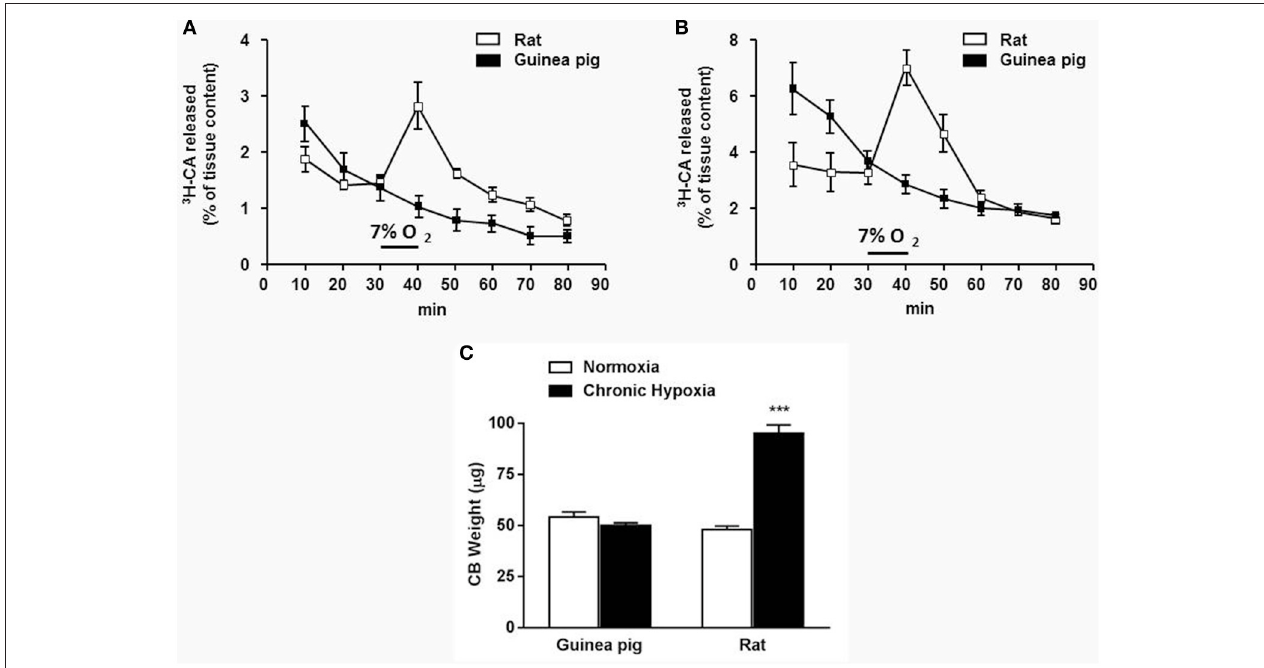
FIGURE 3 | Guinea pig and rat time course of 3 H-CA secretion elicited by 7% O 2 from normoxic (A) and chronic hypoxic (B) CB. Data are expressed as mean ± SEM; n = 8–12. (C) Guinea pig and rat CB weight from normoxic and chronic hypoxic animals (exposed to 10–12% O 2 ; 15 days). Data are mean ± SEM of 60 normoxic and 34 chronic hypoxic guinea pigs CB and of 60 normoxic and 48 chronic hypoxic rats CB. *** p < 0.001 chronic hypoxia vs normoxia.